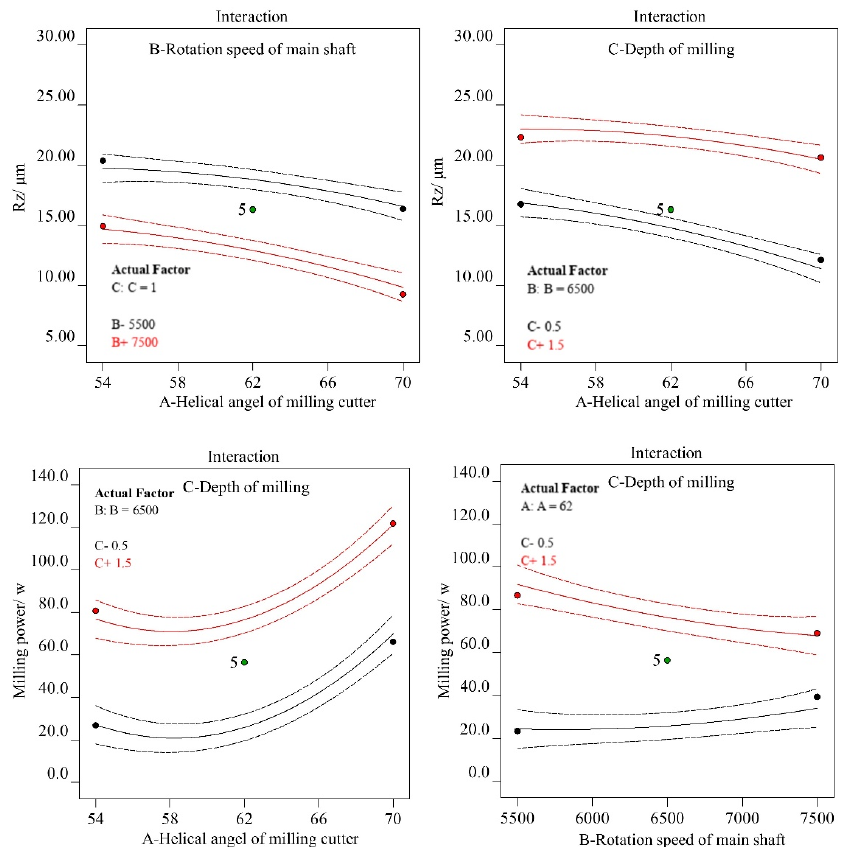
Figure 2. The plot of interaction influences on Ra, Rz, and milling power. Machines 2022 , 10 , 331